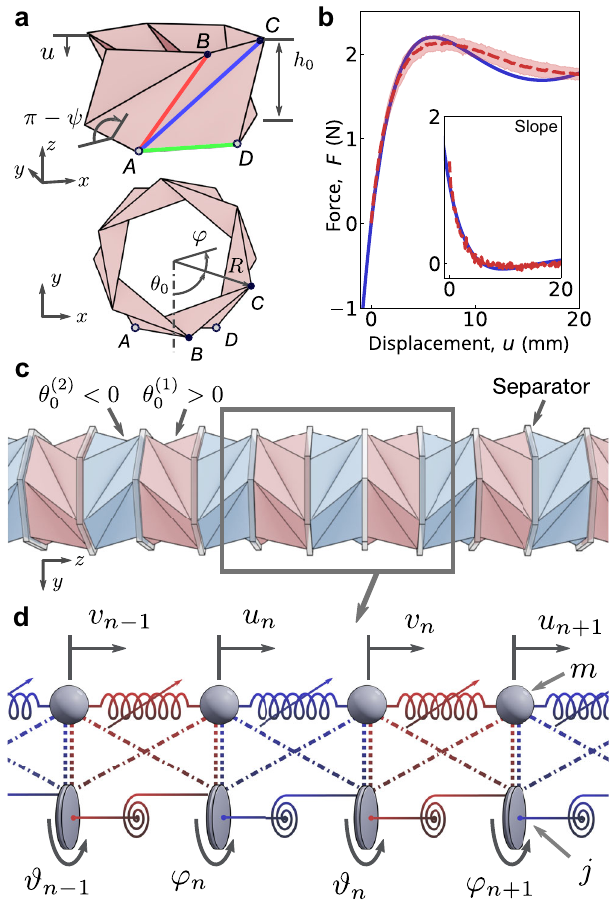
Fig. 1 The schematic illustrations of the system. a The unit cell is depicted in side and top view with geometrical parameters and variables. b The force – displacement relationship of the unit cell under pure axial compression along z -axis is shown for the geometrical parameter h = 30 mm, θ = 70°, and R = 36 mm. Red dashed line, the average force 0 0 of experimental result from 18 unit cells; red shaded area, standard deviation; blue solid line, truss model curve. The inset fi gure shows the slope of averaged experimental and analytical force – displacement curves. c 1D dimer Kresling lattice with polygonal separators. Red-colored unit cells have positive chirality θ ð 1 Þ 0, and the blue-colored unit cells have negative 0 > chirality θ ð 2 Þ 0. d Coupled 1-dimensional phononic lattice as a model of 0 < Kresling lattice. Polygonal separators are modeled as lumped mass m and disc j . Lumped masses are connected with nonlinear springs, and so are the discs. Adjacent masses and discs are connected with nonlinear springs as well, denoted as dashed and dash-dotted